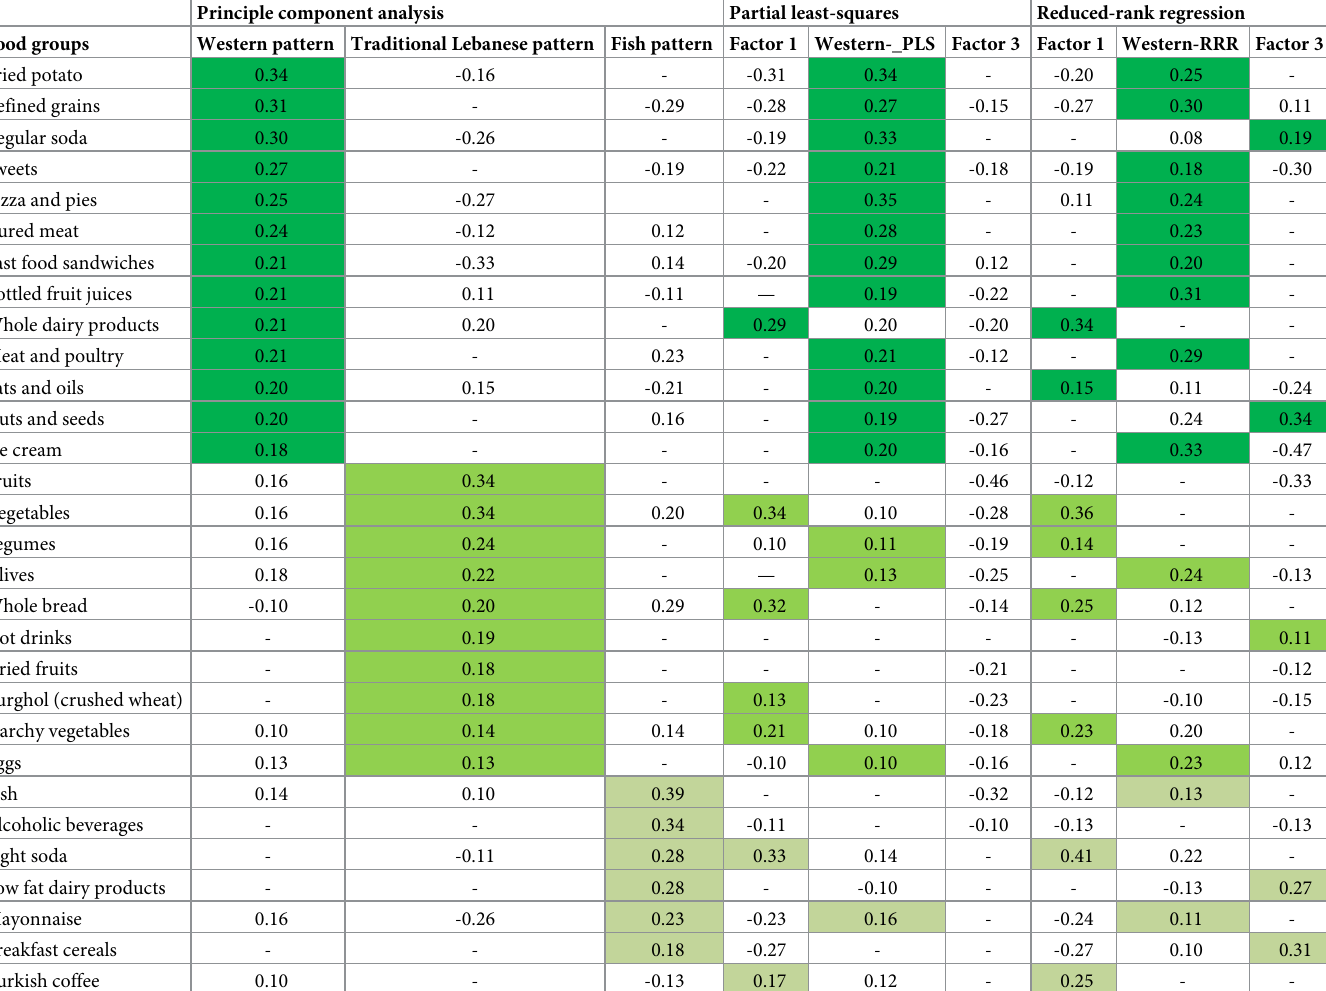
Table 2. Factor loadings of food groups in dietary patterns identified using principle component analysis, reduced-rank regression and partial least-squares (n = 673). Principle component analysis